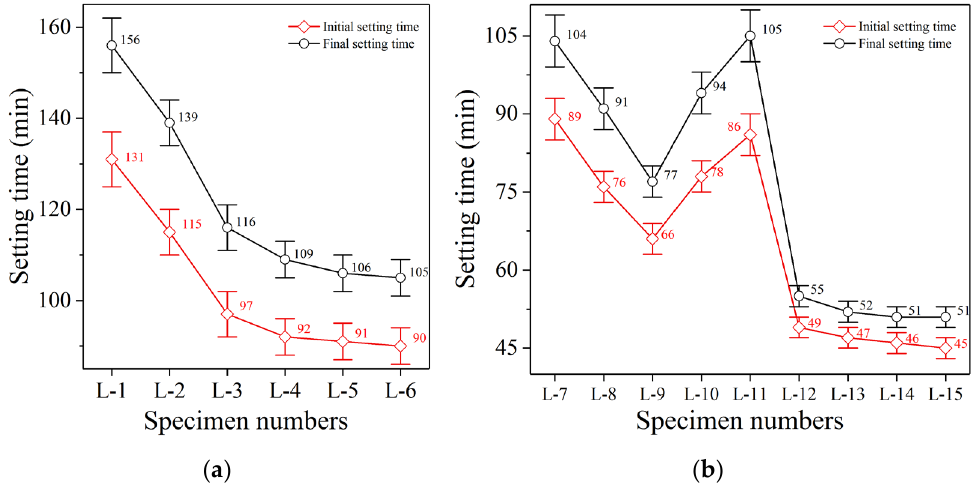
Figure 2. Condensation behavior analysis. ( a ) Specimens L-1 to L-6. ( b ) Specimens L-7 to